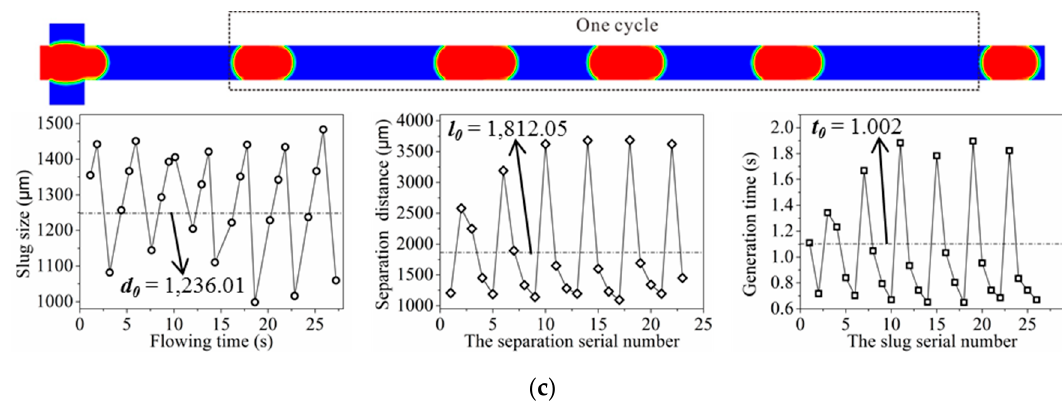
Figure 8. Slug generation obtained from numerical simulations for a triangle wave dynamic dispersed injection flow rate. ( a ) The slug generation for the condition of a triangle wave dynamic dispersed injection flow rate with a cycle of 2 t 0 ; ( b ) The slug generation for the condition of a triangle wave dynamic dispersed injection flow rate with a cycle of 3 t 0 ; ( c ) The slug generation for the condition of a triangle wave dynamic dispersed injection flow rate with a cycle of 4 t 0 .